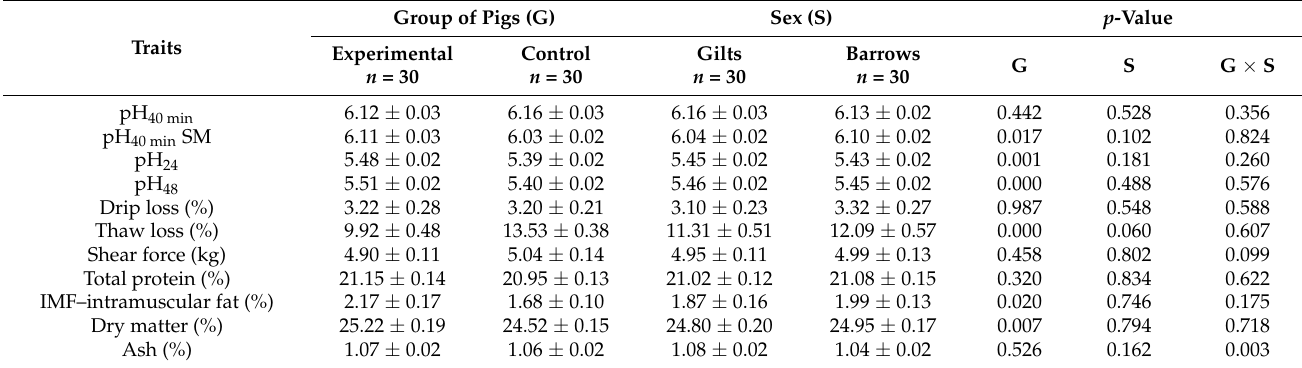
Table 5. Physicochemical traits of the LL and the SM muscle.